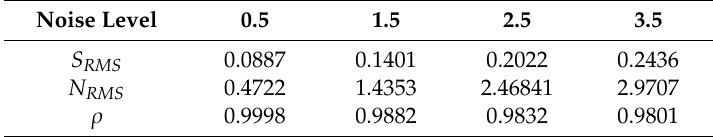
Table 3. Indicators of the WP-TD algorithm in di ff erent Gaussian white noise simulation Table 1. Performance indicators of the WT algorithm in different Gaussian white noise simulation environments.